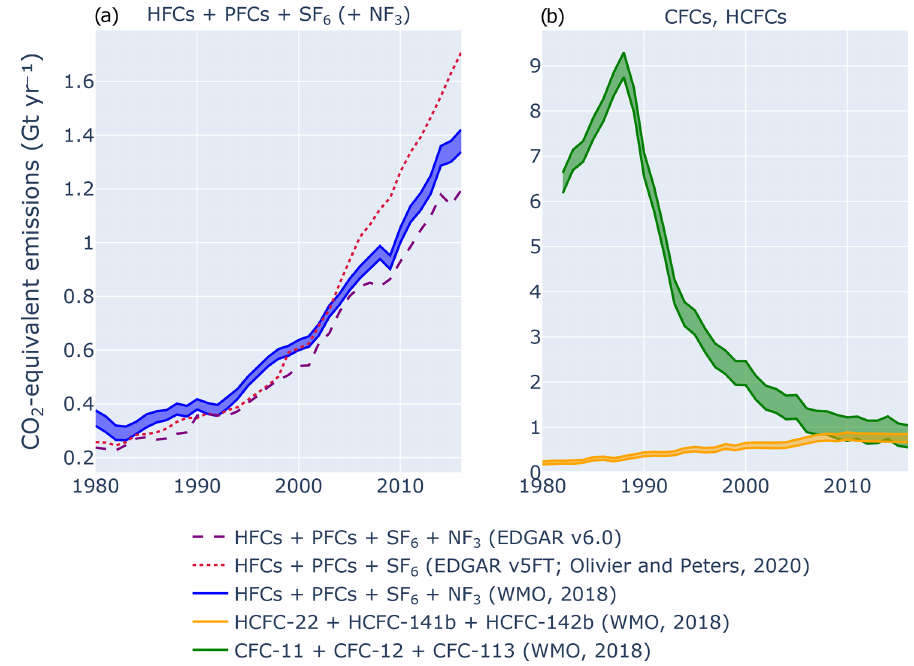
Figure 3. Comparison between top-down estimates and bottom-up EDGAR inventory data on GHG emissions for 1980–2016. (a) Total GWP-100-weighted emissions based on IPCC AR6 (Forster et al., 2021) of F-gases in Olivier and Peters (2020) (EDGARv5FT) (red dashed line, excluding C 4 F 10 , C 5 F 12 , C 6 F 14 , and C 7 F 16 ) and EDGARv6 (purple dashed line) compared to top-down estimates based on AGAGE and NOAA data from WMO (2018) (blue lines; Engel and Rigby, 2018; Montzka and Velders, 2018). (b) Top-down aggregated emissions for the three most abundant CFCs (-11, -12, and -113) and HCFCs (-22, -141b, -142b) not covered in bottom-up emissions inventories are shown in green and orange. For top-down estimates the shaded areas between the two respective lines represent 1 σ